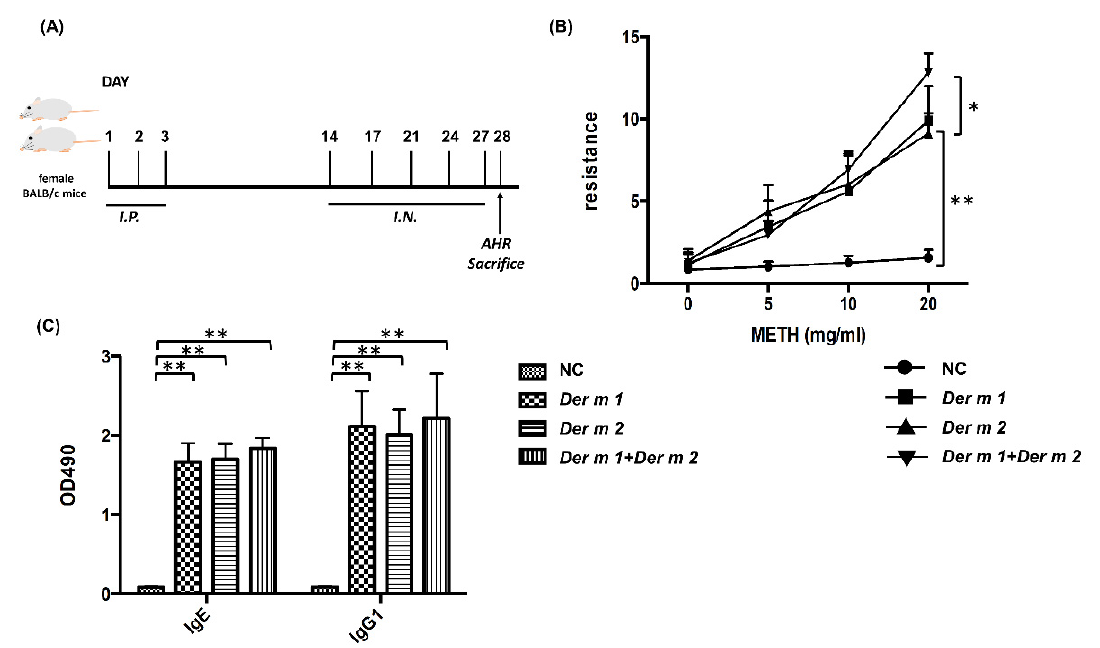
Figure 4. Female BALB/c mice were sensitized/challenged with major recombinant allergens Der m 1 , 2 , or the combination of Der m 1 and Der m 2 . ( A ) In the mice sensitization schedule, the mice were intraperitoneally injected with the allergen or not in the first three days, and were intranasal allergens administration at days 14, 17, 21, 24, and 27, for a total 5 days. After the airway hyperactivity (AHR) determination, the mice were sacrificed on day 28. ( B ) The AHR to methacholine was assessed with the Buxco system. Normal group (NC) is shown as ( ● ), Der m 1 sensitization group is shown as ( ■ ), Der m 2 sensitization group is shown as ( ▲ ), and Der m 1 + Der m 2 sensitization group is shown as ( ▼ ). ( C ) Sera in allergen-specific IgE and allergen-specific IgG1 concentrations were obtained from the NC group, Der m 1 , Der m 2, and Der m 1 + Der m 2 sensitized/challenged mice. ** p < 0.01, * p < 0.05 compared with NC.